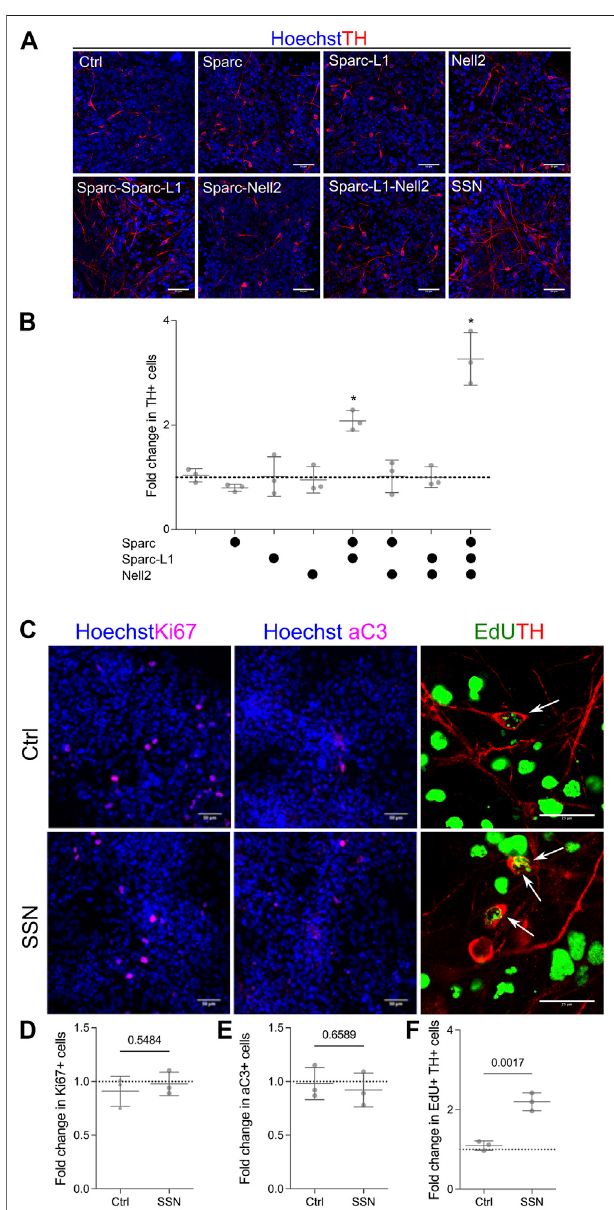
FIGURE 2 | ECM arrays identify matricellular proteins that enhance the number ofTH+neurons. (A) Immuno fl uorescence images ofcellscultured on EHS laminin (control) or with matricellular proteins showing increased TH immunoreactivity in response to Sparc, Sparc-L1 and Nell2. (B) Quanti fi cation of images con fi rming that the synergistic action of Sparc and Sparc-L1 enhances the number of TH+ neurons and that this is further increasedwiththeadditionofNell2(ANOVAwithTukey ’ smultiplecomparison test p < 0.0001). (C) Immuno fl uorescence images of Ki67 (proliferation), activated caspase 3 (aC3, apoptosis) and EdU/TH (neurogenesis). Matricellular proteins do not appear to impact (D) proliferation or (E) survival but do increase (F) neurogenesis, that is, the number of EdU and TH double positive cells (unpaired t -test, p values shown on graph). Data presented as mean fold change of percentage positive cells from three independent experiments ( N (cid:1)